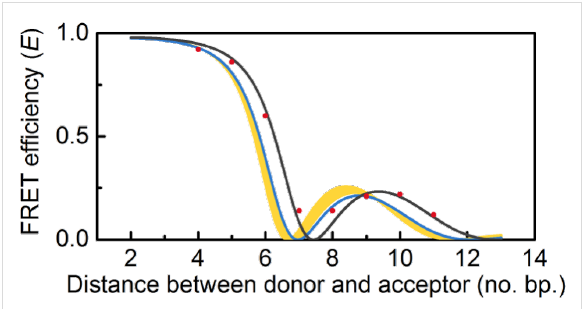
Figure 6: FRET efficiency as a function of number of base pairs sepa- rating the donor (qAN1) and acceptor (qA nitro ). Red dots mark the measured FRET efficiency with netropsin bound. The black line shows the best fit to the data based on FRET theory. The blue line shows the curve for B DNA. The yellow area depicts the range possible if each netropsin molecule overwinds the DNA as stated in previous literature.